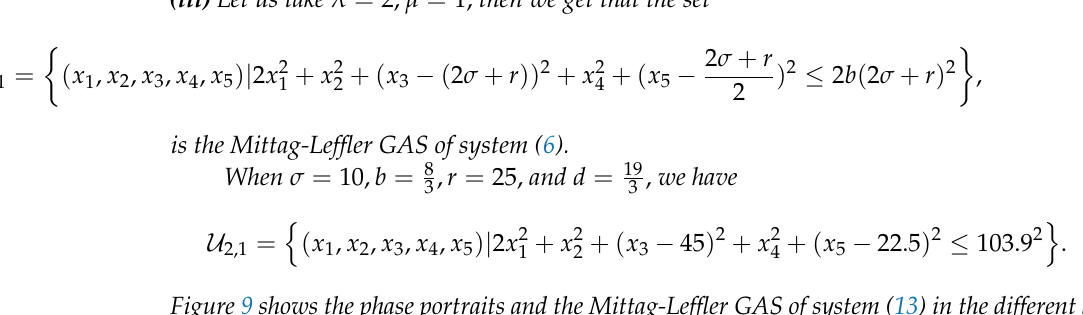
Figure 8. The phase portraits and the Mittag-Leffler GAS ( r = 25, and d = 19 3